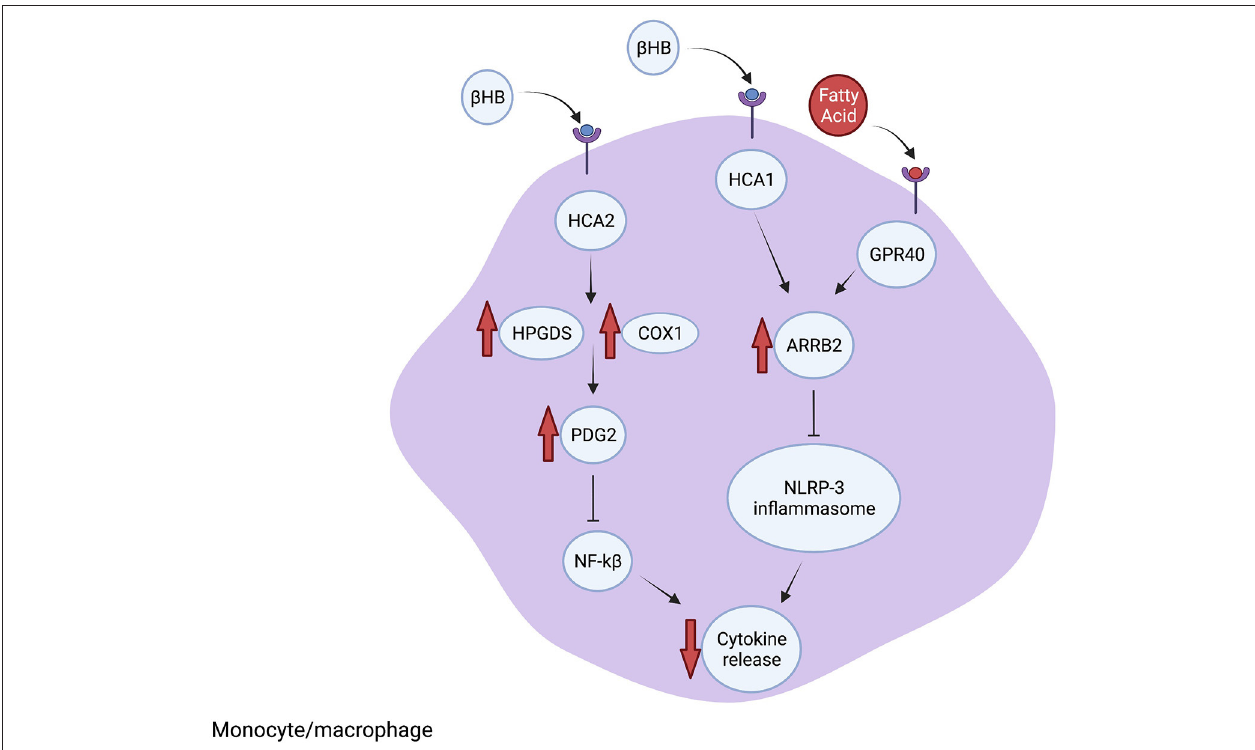
FIGURE 2 | The KD reduces inflammation. The scaffolding protein ARRB1 is elevated after BHB binds to HCA1 or fatty acids (FA) bind to GPR40. Increased ARRB1 inhibits the NRLP-3 inflammasome formation, which reduces cytokine processing and release. Furthermore, BHB interacting with HCA2 leads to increased PDG2 synthesis through increased HPGDS and COX1, which leads to inhibition of NF-kB and suppressed inflammatory signaling. Additional anti-inflammatory mechanisms are described in the text.